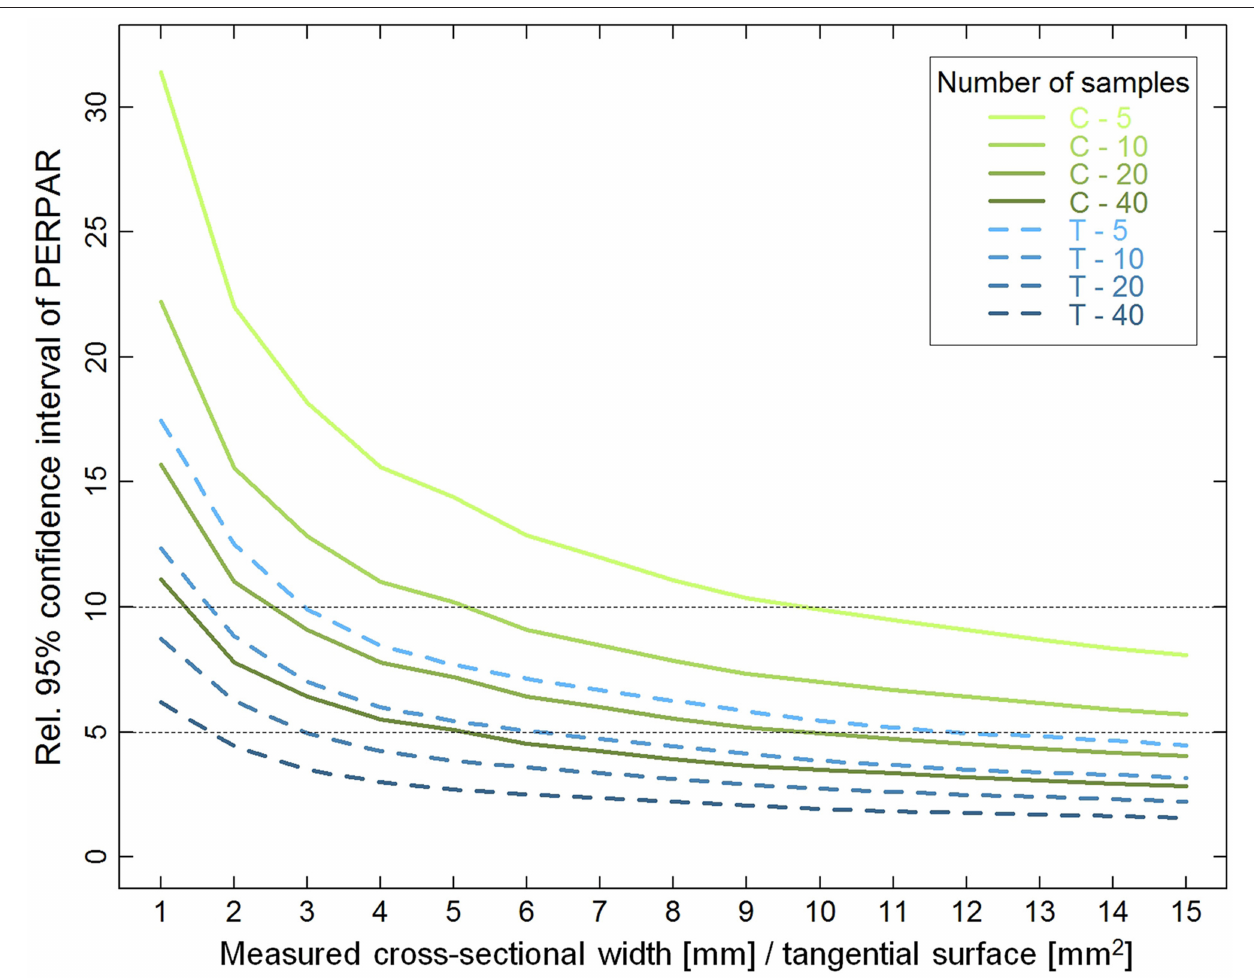
FIGURE 5 | Relative 95% confidence interval (CI95) of percentage of ray surface (PERPAR) as a function of measured wood width (cross-sections; C; green solid lines), surface (tangential sections; T; blue dashed lines), and number of samples. The dotted horizontal lines delimit a band that might represent a reasonable balance between data accuracy and measurement efficiency. See Materials and Methods section for further